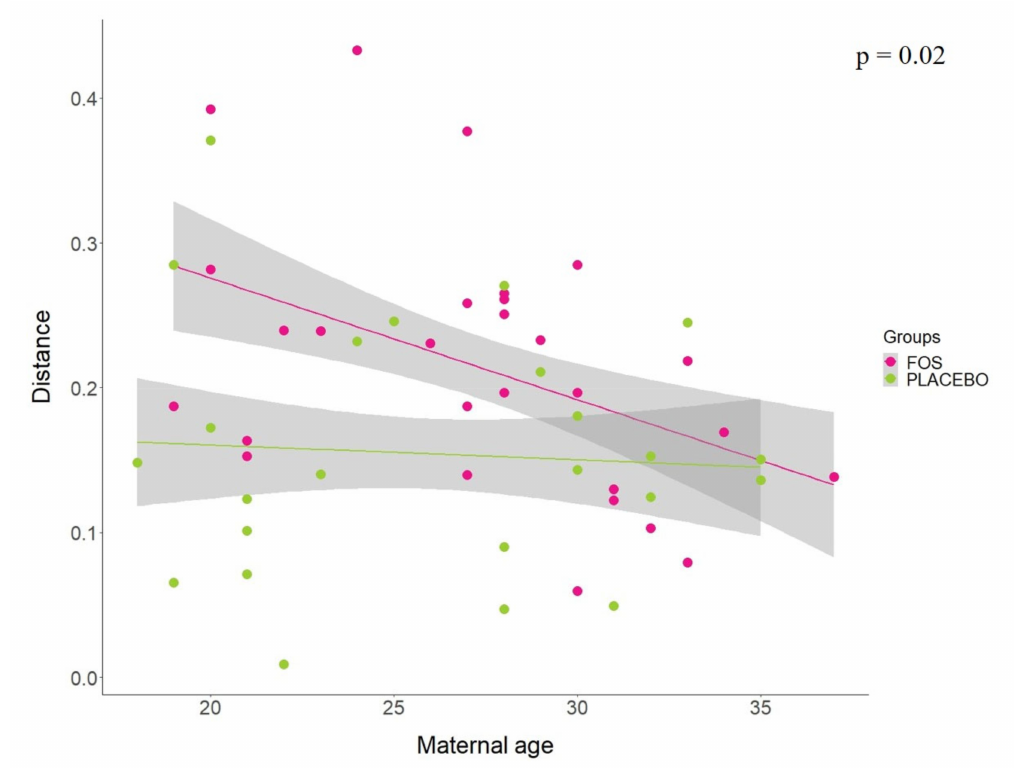
Figure 4. Jensen–Shannon distance between “before” and “after” the supplementation by FOS (pink) or placebo (green) groups, according to the maternal age. Least-squares means was used to compare the slopes of the regression of distance vs. maternal age between FOS and placebo